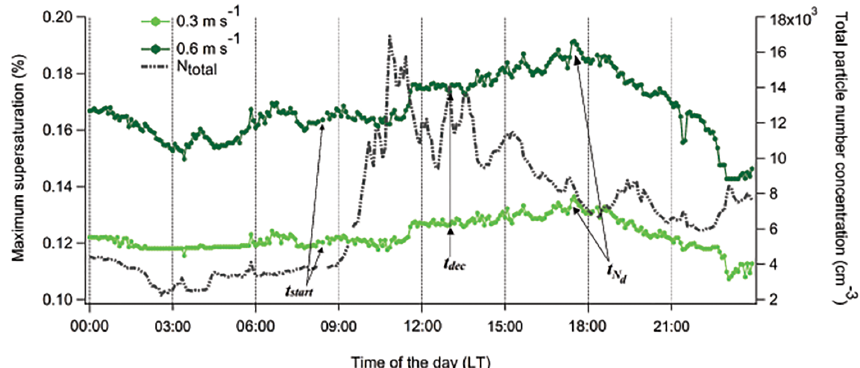
Figure 6. Diurnal evolution of the calculated maximum supersaturation ( s max ) (lest axis) and total aerosol particle number concentrations ( N total ) (right axis) for updraft velocities of σ w = 0 . 3ms − 1 and σ w = 0 . 6ms − 1 during the “representative” new particle formation event captured at Finokalia on 29 August